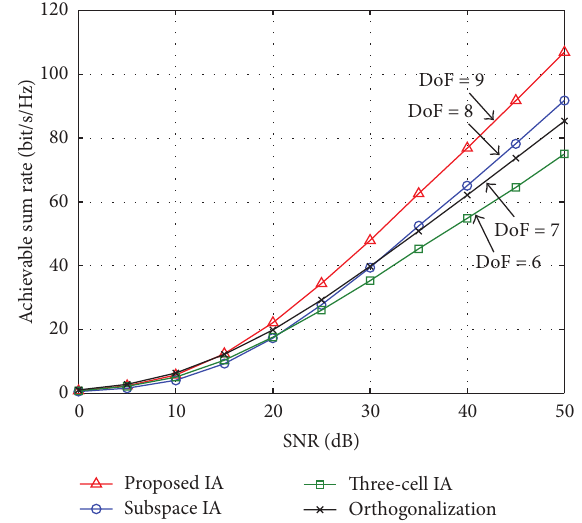
Figure 3: Ergodic sum rate versus SNR for (𝐿,𝐾,𝑀,𝑁) = (3,3,7,5)